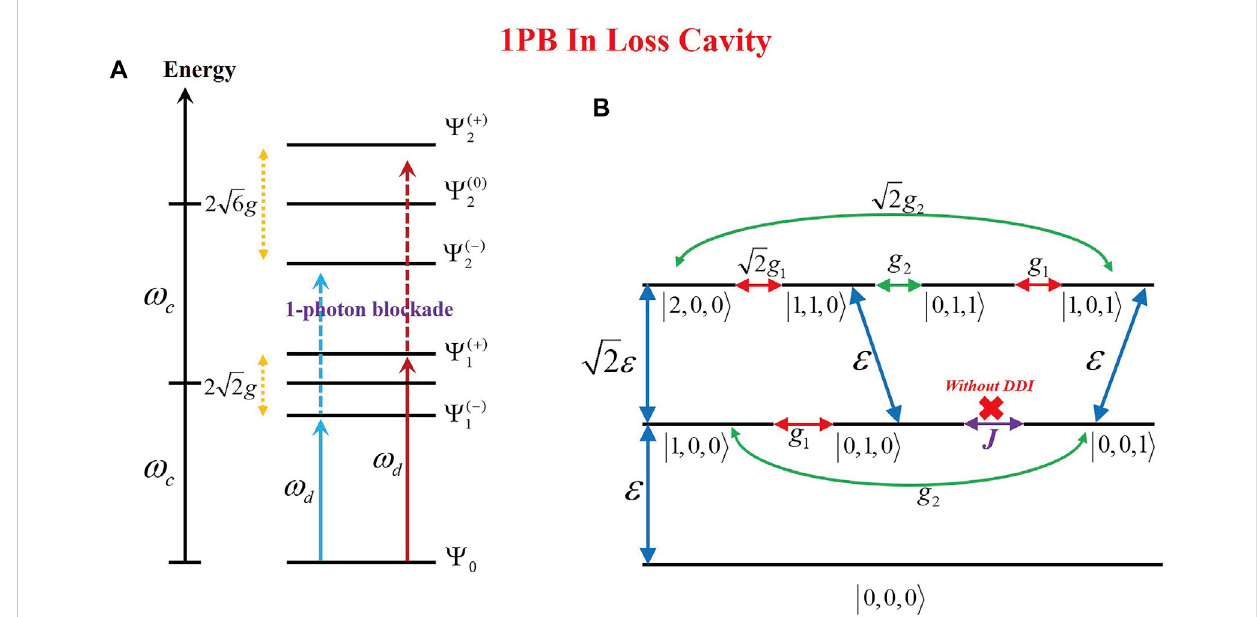
FIGURE 3 (A) Anharmonic ladder-type energy-level diagram to explain the PBeffect inthe system with thelosscavity. (B) Quantum transition pathways of the system for different quantum states | r 〉 | s 〉 | t 〉